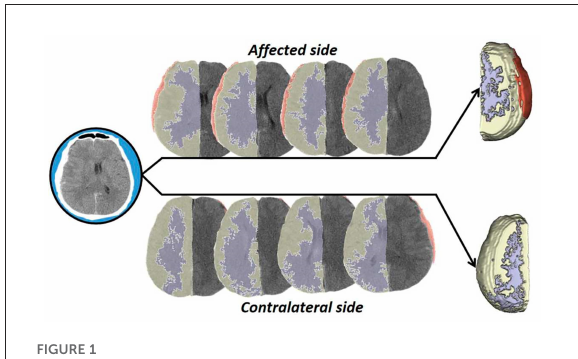
FIGURE1 Operation flow diagram. In this study, the brain tissue CT data were processed by stratification and 3D synthesis, and the density difference was compared and